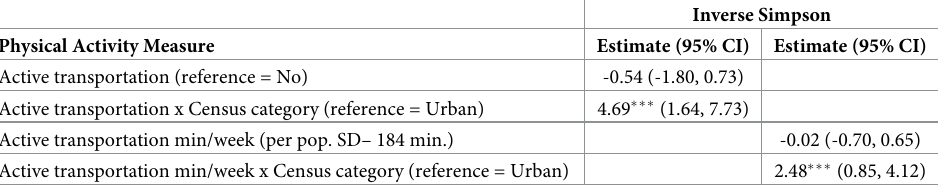
Table 3. Linear mixed effects model estimates of the relationship between physical activity and alpha-diversity, summary of models with